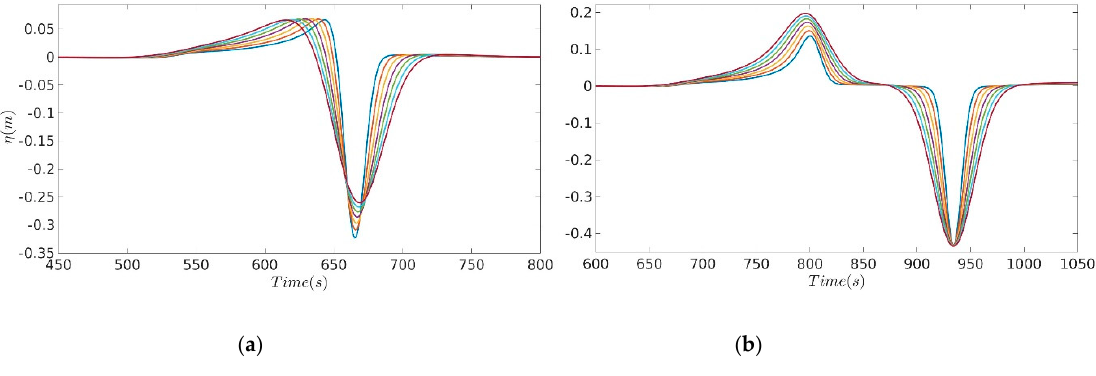
Figure 8. Time series of surface displacement (at x = − 100 m in Figure 7c), normalized by its absolute minimum value (red) and Gaussian-shape radiation stress normalized by its maximum value (black), for the longer forcing case shown in Figure 7b. 3. Bound Wave Dissipation after Short Wave Breaking One important question yet to be fully answered is what happens to the bound wave after short wave breaking? Different datasets indicate bound wave release [12,13], while others indicate dissipation of the forced wave in the surf zone [17,24,36,38]. Baldock [15] suggested that the relationship between short and infragravity wave with water depth at the breakpoint is important to determine whether the bound wave is released or if it remains forced, decaying with the dissipation of the short waves. During the breaking process, three different conditions are possible: i) at the breaking point both the short and forced waves are not in shallow water, 𝑐 (cid:3034) < (cid:3493)𝑔ℎ and the length of the bound wave is not much longer than h ; ii) the bound wave is much longer than h, but the short waves are not, hence the bound wave number differs from the wave number of a free wave with